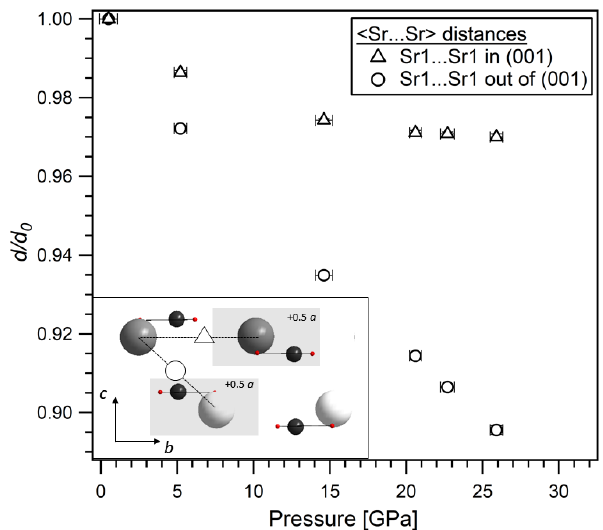
Figure 6. Evolution with pressure of the (cid:104) Sr ··· Sr (cid:105) distances in the (001) plane (distance between two grey Sr spheres) and out of the (001) plane (distance between grey and white Sr spheres) in SrCO 3 - I derived from single-crystal X-ray diffraction data. A schematic drawing of the crystal structure of SrCO 3 -I in the (100) plane is given as an